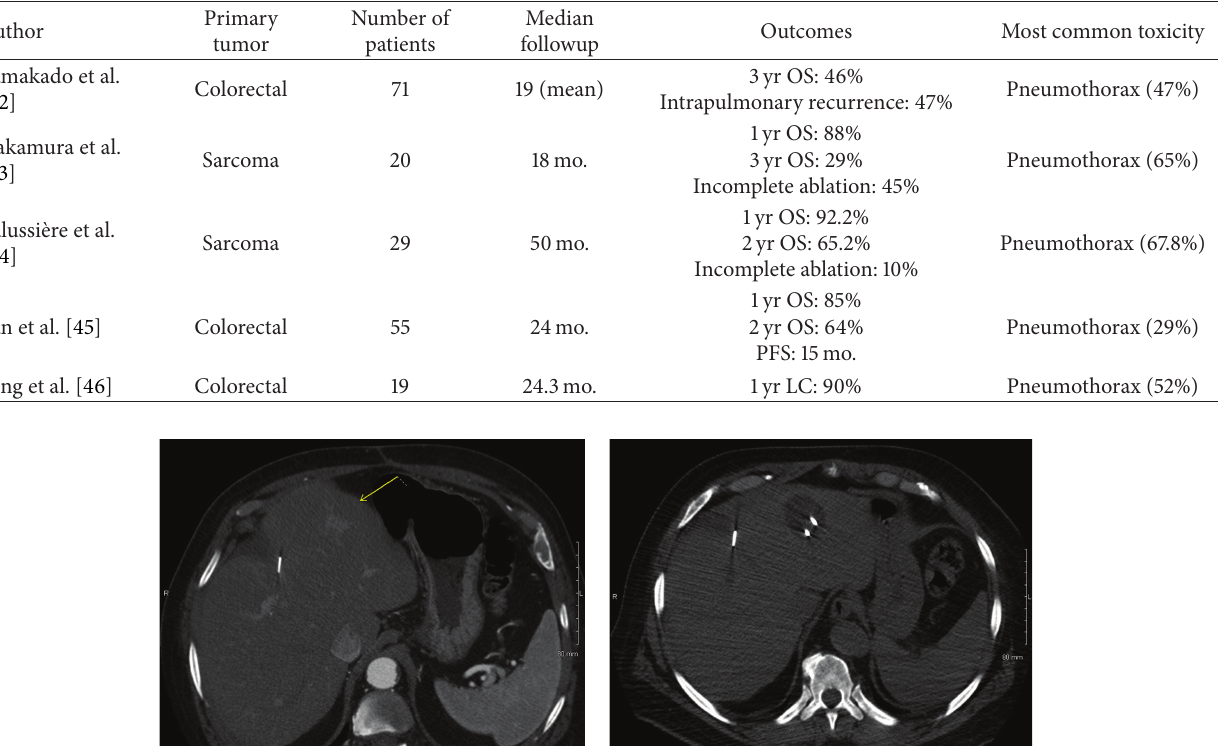
Table 4: Summary of RFA studies in metastatic disease.